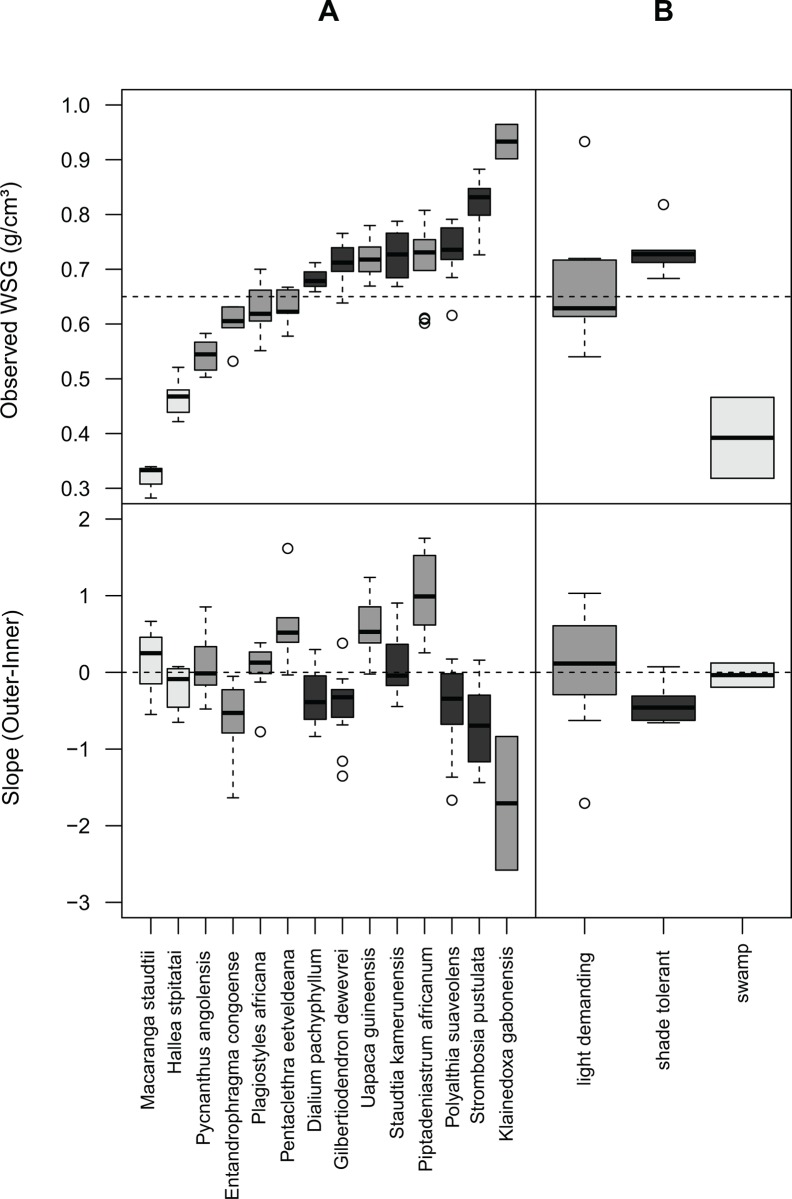
Boxplots of the WSG and of the slope calculated between the outer-WSG and the inner-WSG for the 14 species (A) and the corresponding regeneration guilds (B) investigated in Malebo, the Democratic Republic of the Congo.The color corresponds to the regeneration guild with swamp, light-demanding and shade-tolerant species respectively colored in light grey, grey and dark grey, respectively.